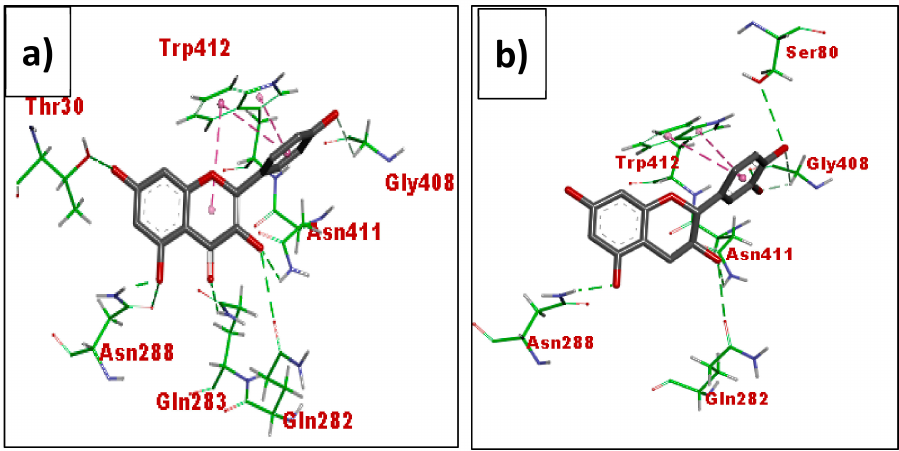
Figure 15. Binding interactions of kaempferol (MN11) ( a ), (-)-epicatechin (MN14) ( b ) with active site residues of Glut1 (PDB ID: 5EQI). The compounds are coloured black while amino acids are green. Green and purple dashes depict hydrogen bond and hydrophobic bond,